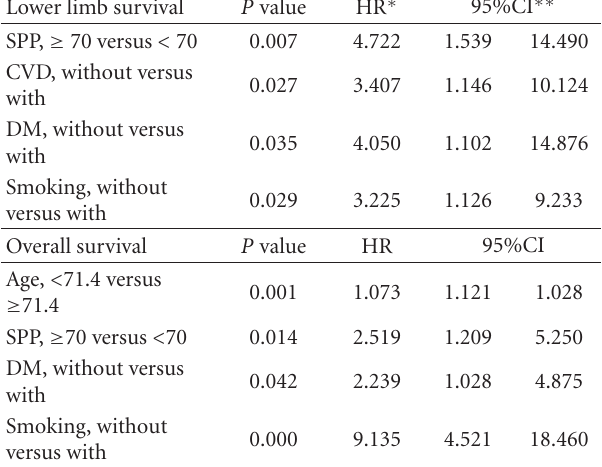
Table 3: Independent risk factors for lower limb survival and overall survival by Cox regression analysis. SPP < 70, presence of CVD, DM, and smoking showed significantly increase the risk for lower limb survival (hazard ratios increased 4.722, 3.407, 4.050, 3.225 times, resp.), and age ≥ 71.4, SPP < 70, presence of DM, and